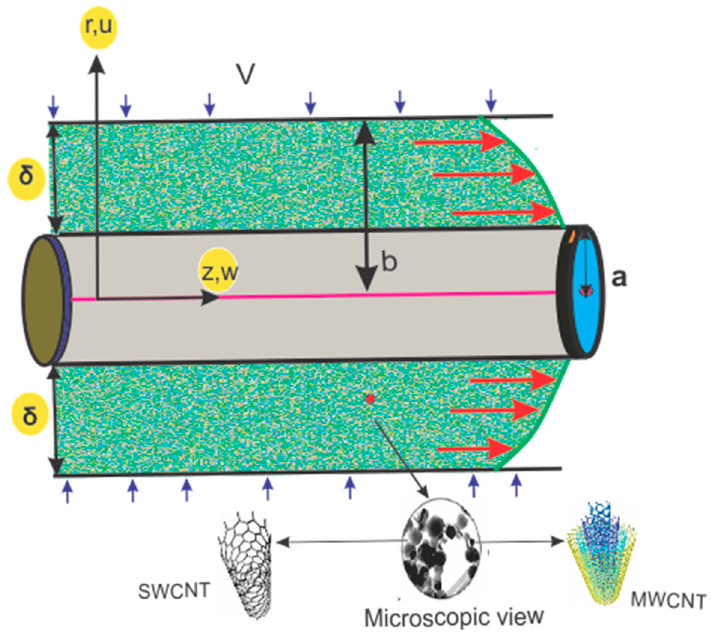
Figure 1. Geometry of the proposed problem for the thin film nanofluid flow. Processes 2019 , 7 , x FOR PEER REVIEW